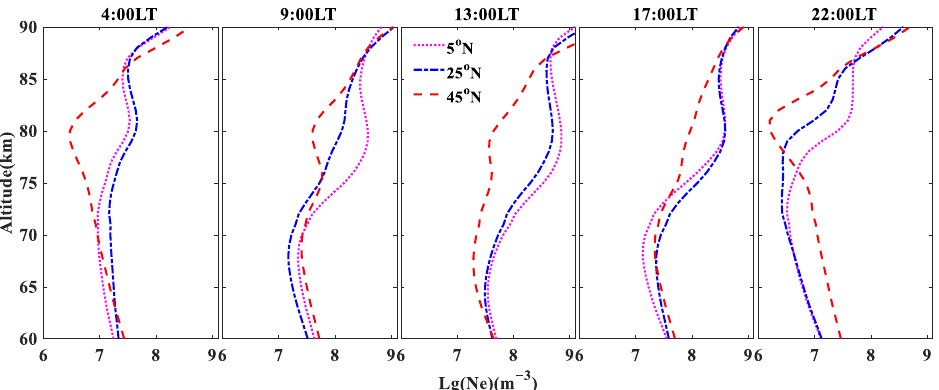
the lower boundary of the D-region changes with the local time within 72 – 85 km at night in the low latitude. Figure 5. The variation of the electron density of the model with the local time in 2009 at different latitudes (5°N, 25°N, and 45°N) in the mid-low latitude region.